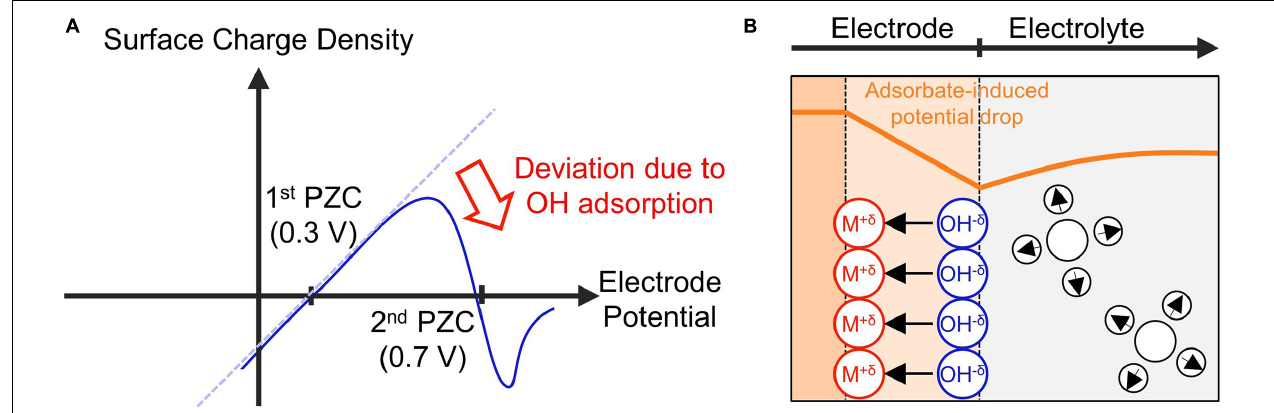
FIGURE 4 | Schematic illustrations of (A) the surface charge density with respect to the potential and (B) the structure of the electrode – electrolyte interface near the second PZC.